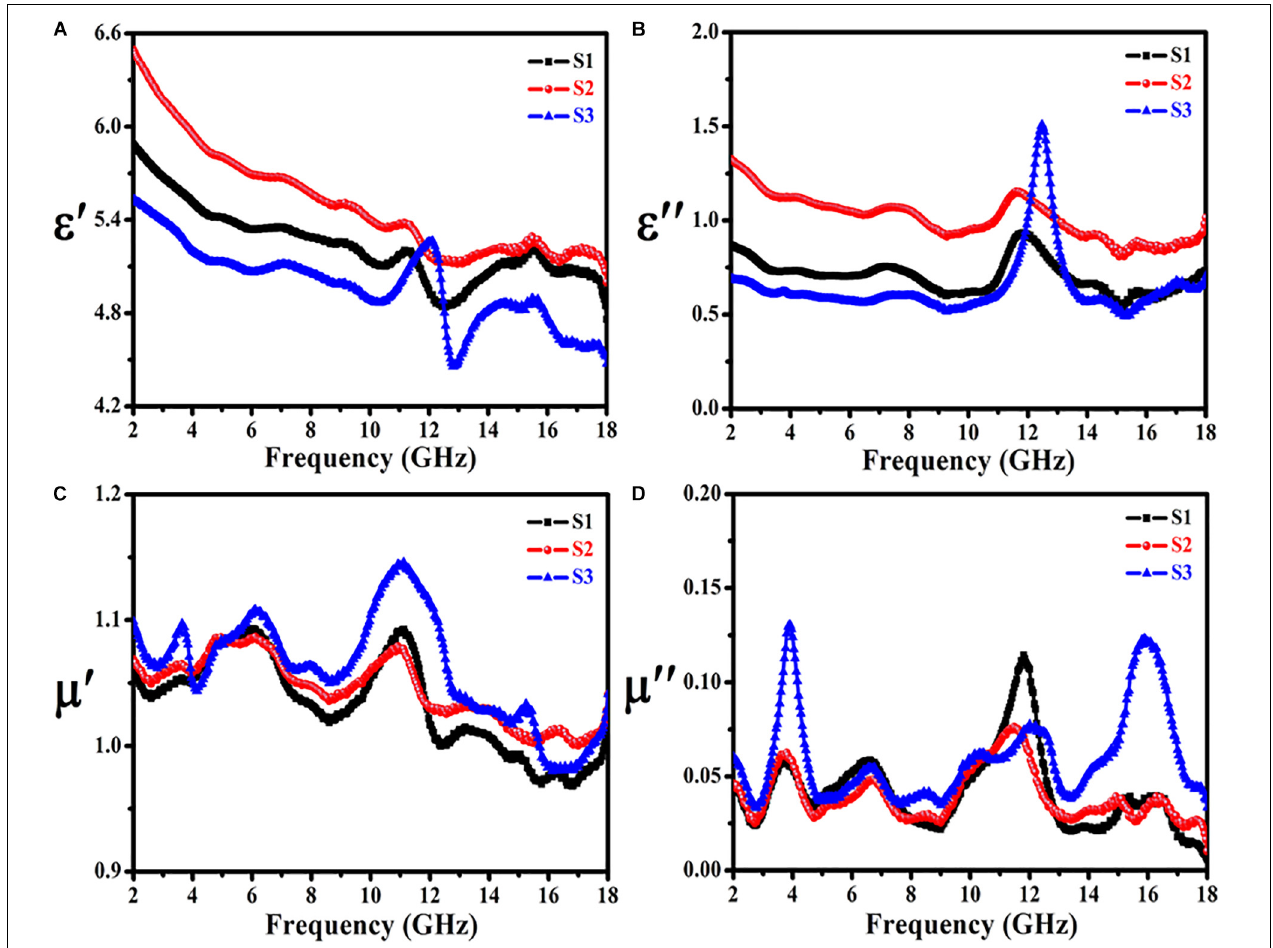
FIGURE 10 | EM parameters for the as-prepared samples: (A,B) complex permittivity, and (C,D) complex permeability.